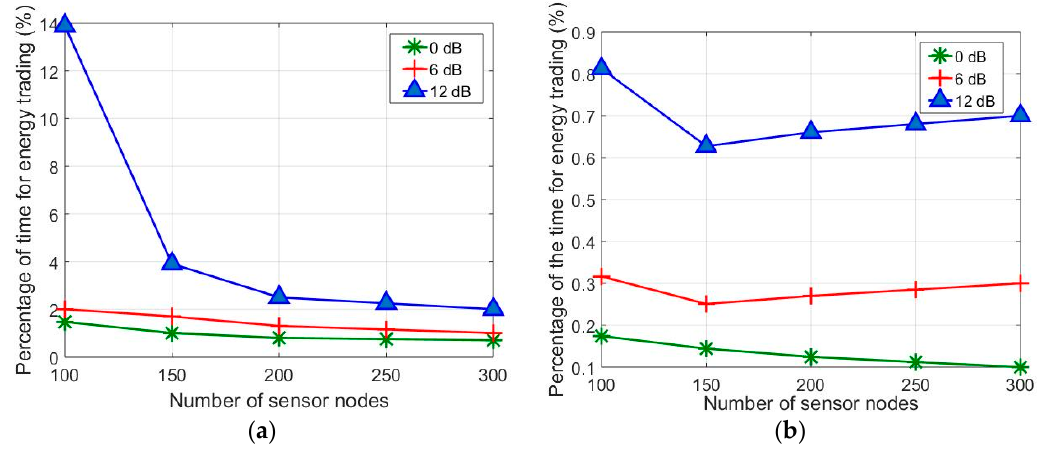
Figure 11. Percentage of time for energy trading over total charging time with different antenna gains and charging efficiency: ( a ) T f = 0.05; and ( b ) T f = 0.01.